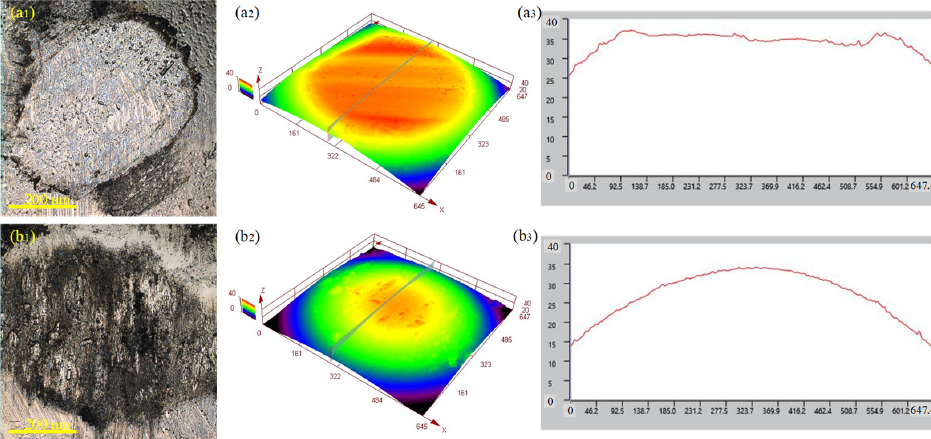
Figure 9. Optical and 3D morphology of the GCr15 ball after wear test: (a1–a3) for 316L coating and (b1–b3) for composite coating.